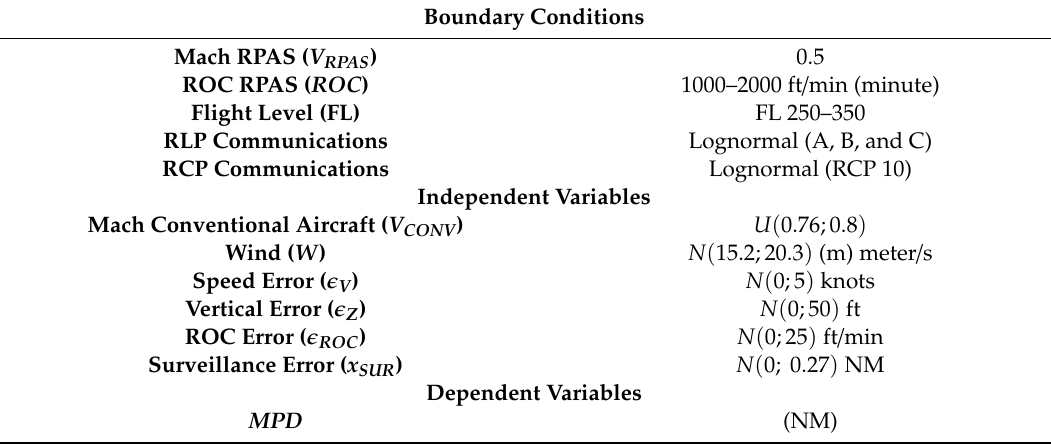
Table 4. Boundary conditions, independent and dependent variables for the Monte Carlo